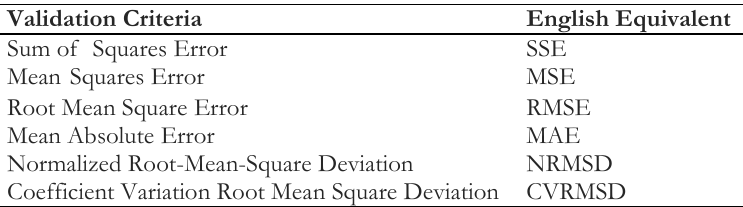
Table 2. Predictive algorithm validation methods.